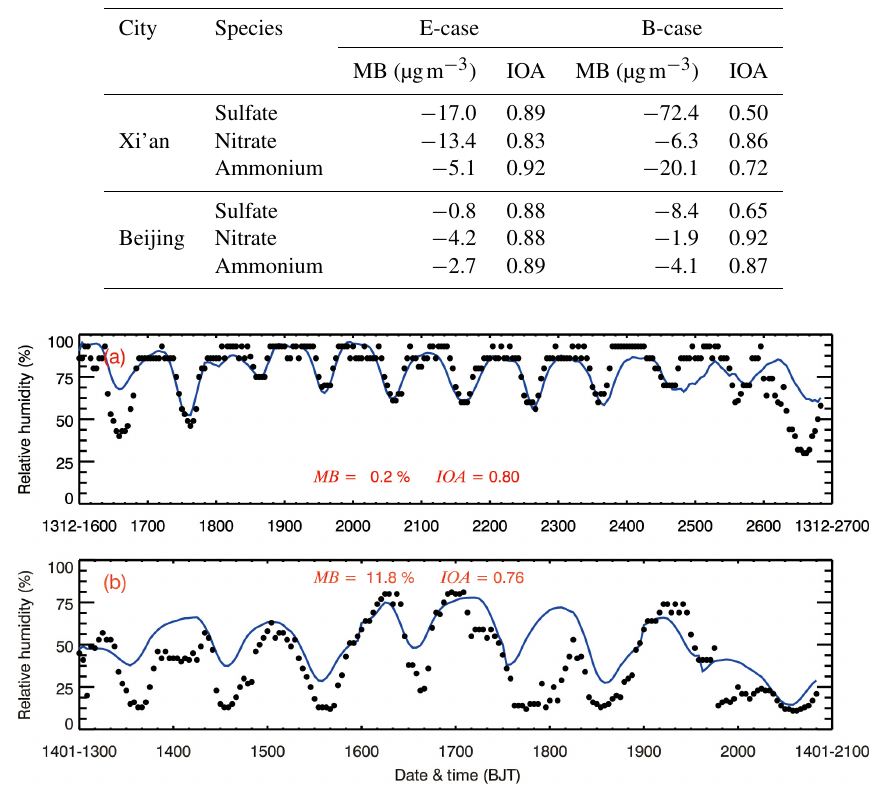
Figure 13. Comparison of measured (black dots) and simulated (blue lines, in the E-case) diurnal profiles of the relative humidity (a) in Xi’an from 16 to 27 December 2013 and (b) in Beijing from 13 to 21 January